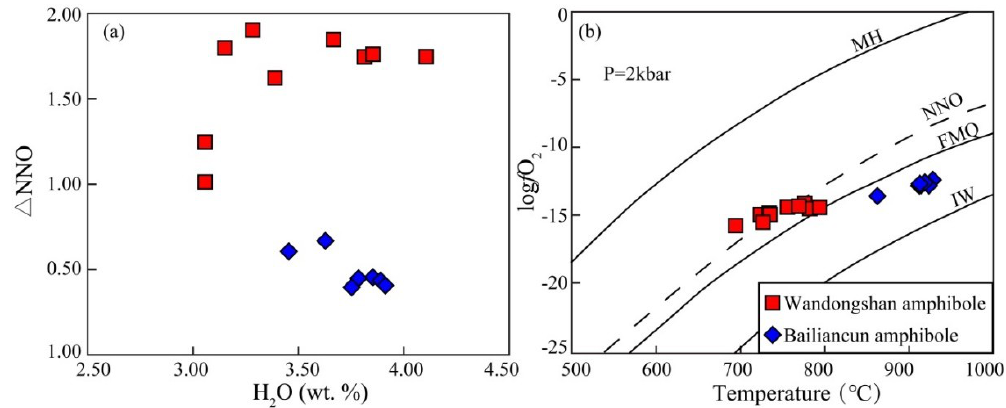
Figure 6. Magmatic oxidation state of intrusions in the Wandongshan and Bailiancun districts, estimated from amphibole compositions. ( a ) Magma oxidation state ( ∆ NNO) of Wandongshan and Bailiancun porphyries; ( b ) magmatic f O 2 (log f O 2 ) vs. magmatic temperature. MH: magnetite-hematite buffer curve; NNO: nickel-nickel oxide buffer curve; FMQ: fayalite-magnetite-quartz buffer curve; IW: iron-wustite.